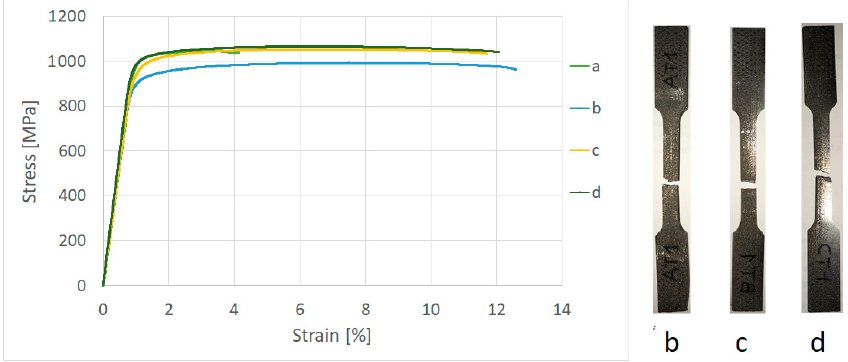
Figure 11. Engineering stress-strain curves of the a–d samples. Data for the a-sample is reported elsewhere [35].